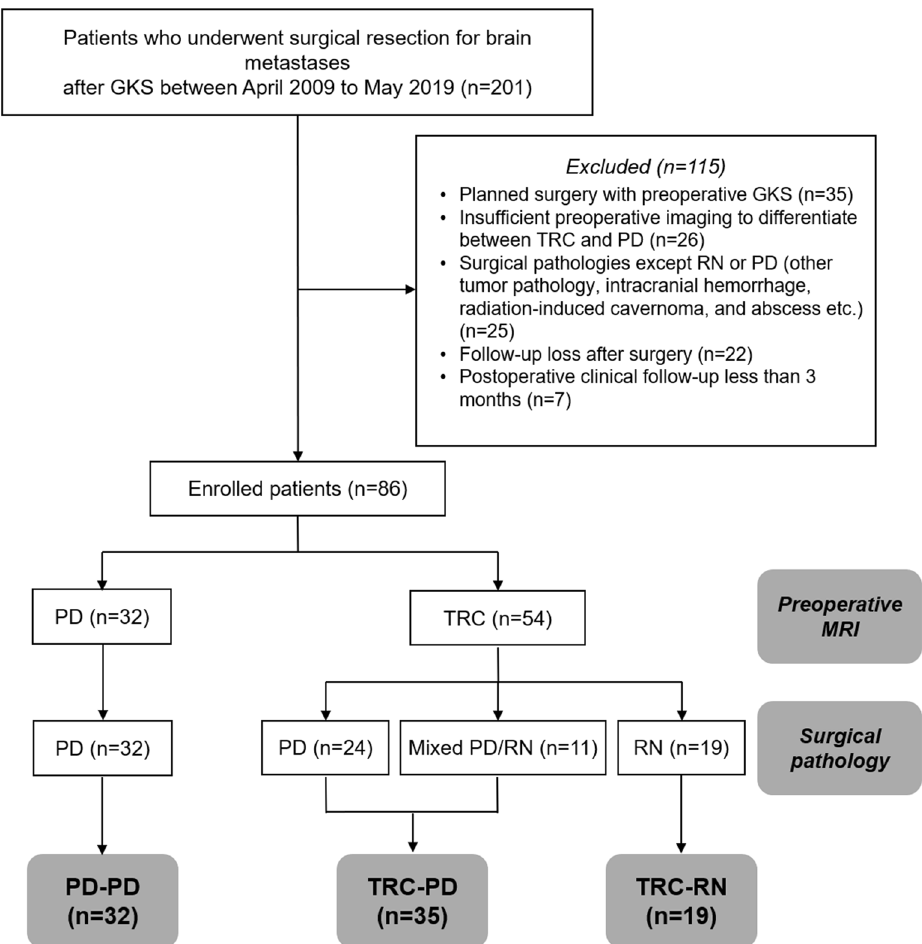
Figure 1. Flow chart of patient enrollment and classification. Eighty-six patients were included and classified into four groups according to preoperative MRI and surgical pathology. For surgical pathology, pure radiation necrosis alone was sorted into “radiation necrosis”. Mixed pathology, containing both metastatic tumor and necrotic cells, was classified as “metastatic cells.” No patient was assigned to the PD-RN group; therefore, the three groups TRC-RN, TRC-PD, and PD–PD were finally incorporated in this study. MRI magnetic resonance imaging, PD progressive disease, RN radiation necrosis, TRC treatment-related